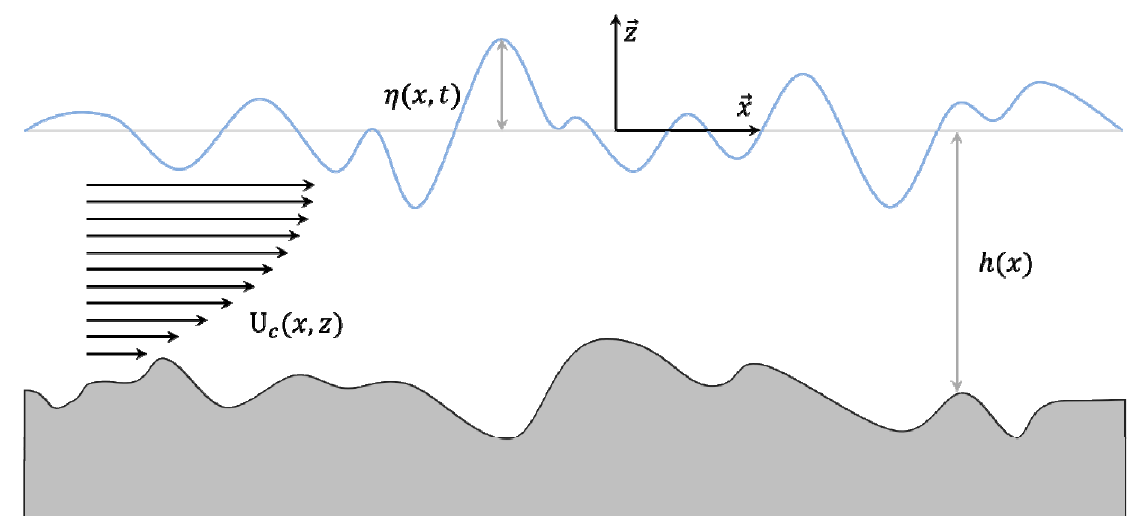
U . Figure 1. Waves propagating in variable bathymetry in the presence of current with velocity U c c